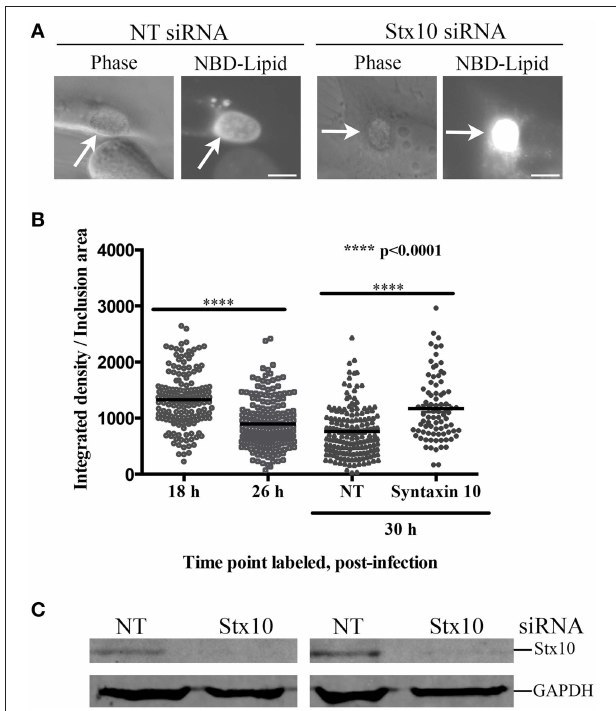
FIGURE 5 | Effect of syntaxin 10 siRNA knockdown on NBD-sphingomyelin trafficking to the chlamydial inclusion. (A) Syntaxin 10 (Stx10) or non-targeting (NT) siRNA-treated HeLa cells were infected with C. trachomatis serovar L2 for 24h, labeled with NBD-ceramide, and treated with back-exchange medium for an additional 3h. Samples were imaged at 40X magnification with a 200ms exposure time using an Axiovert 200M Imager with the AxioCam HRm camera (Carl Zeiss Microscopy, LLC). These images are representative of 3 independent experiments. (B) Untreated HeLa cells were infected with C. trachomatis serovar L2 for 18 or 26h, labeled with NBD-ceramide and back-exchanged for 1.5h. In addition, Stx10 or NT siRNA-treated HeLa cells were infected with C. trachomatis serovar L2 for 30h, labeled and back-exchanged as 18- and 26-h samples. Samples from two independent experiments were imaged using 60X magnification Olympus BX 60 fluorescent scope and images taken with a Nikon DS-Qi1Mc camera, with a 40ms exposure for 18- 26- and NT siRNA treated samples, and a 20ms exposure time for syntaxin 10-treated samples, as described in Materials and Methods. Individual data points, including the mean and standard error of the mean, were graphed using GraphPad Prism 6 software. Statistical analysis included an ordinary One-Way ANOVA with a Tukey’s multiple comparison test. Representative images used in the quantitation are provided in Supplemental Figure 4. (C) A representative Western blot to demonstrate efficient knockdown of Stx10 compared to the loading control